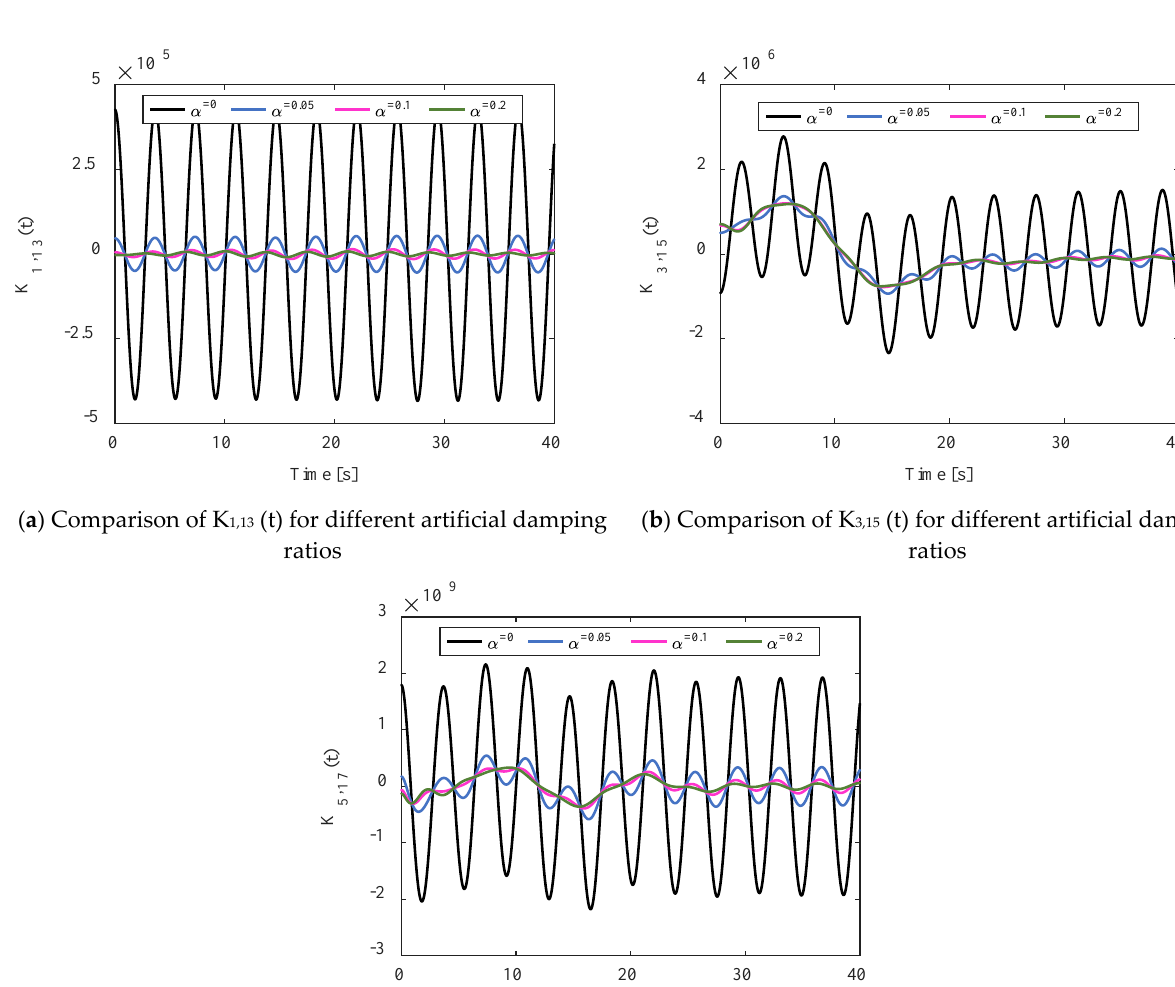
( c ) Comparison of K 5,17 (t) for different artificial damping ratios Figure 15. Comparison of the off-diagonal calculated impulse response functions K 1,13 , K 3,15 , and K 5,17 between the windward module and rear module of the 3-module model.